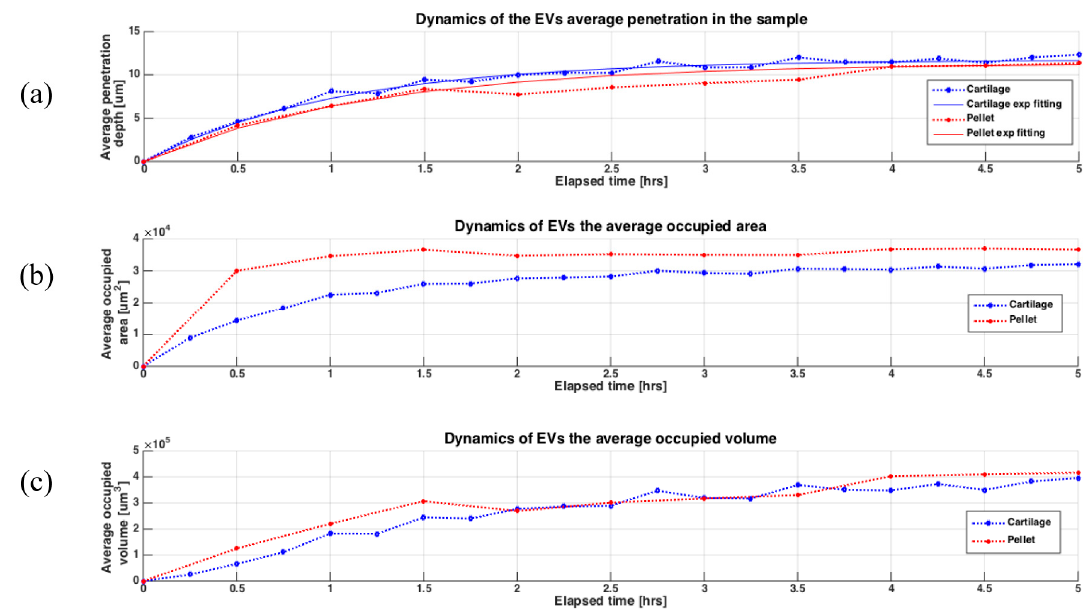
Figure 7. Dynamics of the EV uptake in the samples during the time-lapse experiment in terms of the average thickness of penetration, the average occupied area and the average occupied volume. ( a ) the dotted curves show the average EV penetration depth in the cartilage (blue) and the chondrocytes pellet (red), while the continue curves plot the related exponential fit for the cartilage (blue) and the chondrocytes pellet (red); ( b ) the dotted curves show the average occupied area of the EVs in the cartilage (blue) and the chondrocytes pellet (red); ( c ) the dotted curves show the average occupied volume of the EVs in the cartilage (blue) and the chondrocytes pellet (red).